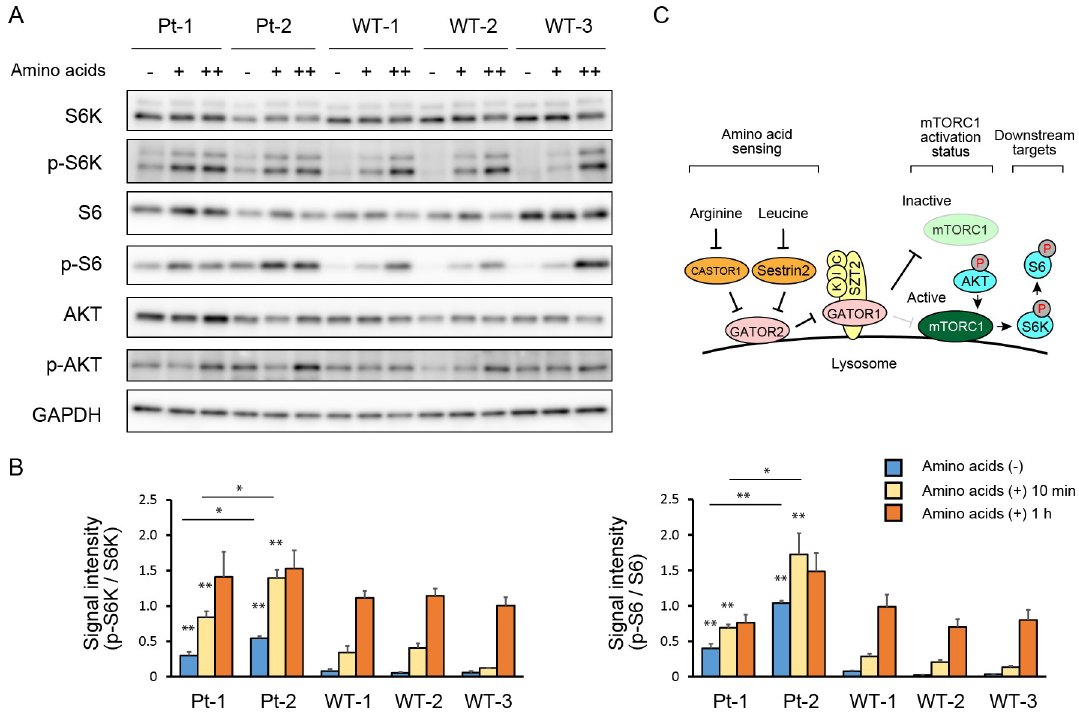
Fig 1. Hyperactivation of mTORC1 signaling under both starved and re-stimulated conditions in the patients. (A) Levels and phosphorylation status of the indicated proteins in the patients and wild-type subjects were determined by immunoblotting. Cells were re-stimulated with amino acids for 10 min (lane +) and 1 h (lane ++). GAPDH was used as a loading control. WT, wild-type. (B) Quantification of the ratio of p-S6K to S6K and p-S6 to S6 bands. Phosphorylation levels of patient 1 and 2 were significantly higher than those of controls under starved and 10 min stimulated conditions, whereas no significant difference after 1 h. Comparing two patients, patient 2 tended to be more activated than patient 1. � p < 0.05. �� p < 0.01. (C) Simplified schema of the amino acid-sensing pathway upstream of mTORC1 and the downstream targets. K, I and C represent KPTN, ITFG2 and C12orf66, respectively. They form KICSTOR complex with SZT2. P denotes phosphorylation.